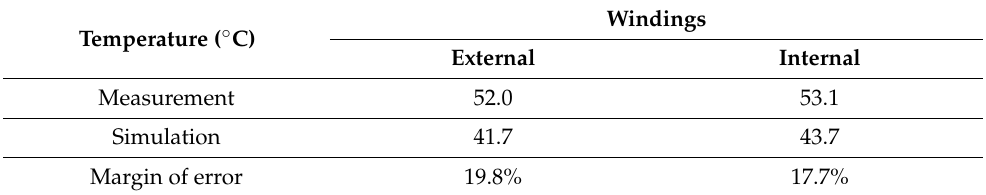
Table 2. Comparison of thermal